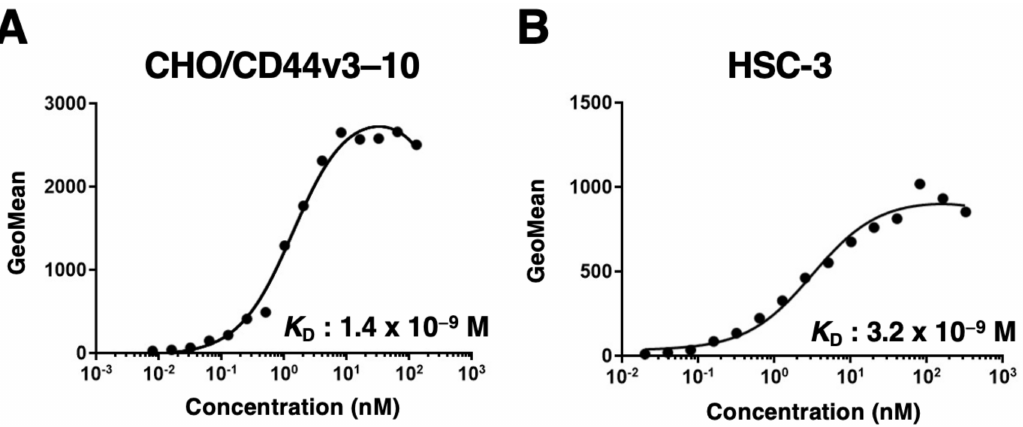
Figure 3. The binding affinity of C 44 Mab-34 to CD44-expressing cells. CHO/CD44v3–10 ( A ) and HSC-3 ( B ) cells were suspended in serially diluted C 44 Mab-34 at indicated concentrations. Then, cells were treated with anti-mouse IgG conjugated with Alexa Fluor 488. Fluorescence data were collected, followed by the calculation of the dissociation constant ( K D ) by GraphPad PRISM 8.